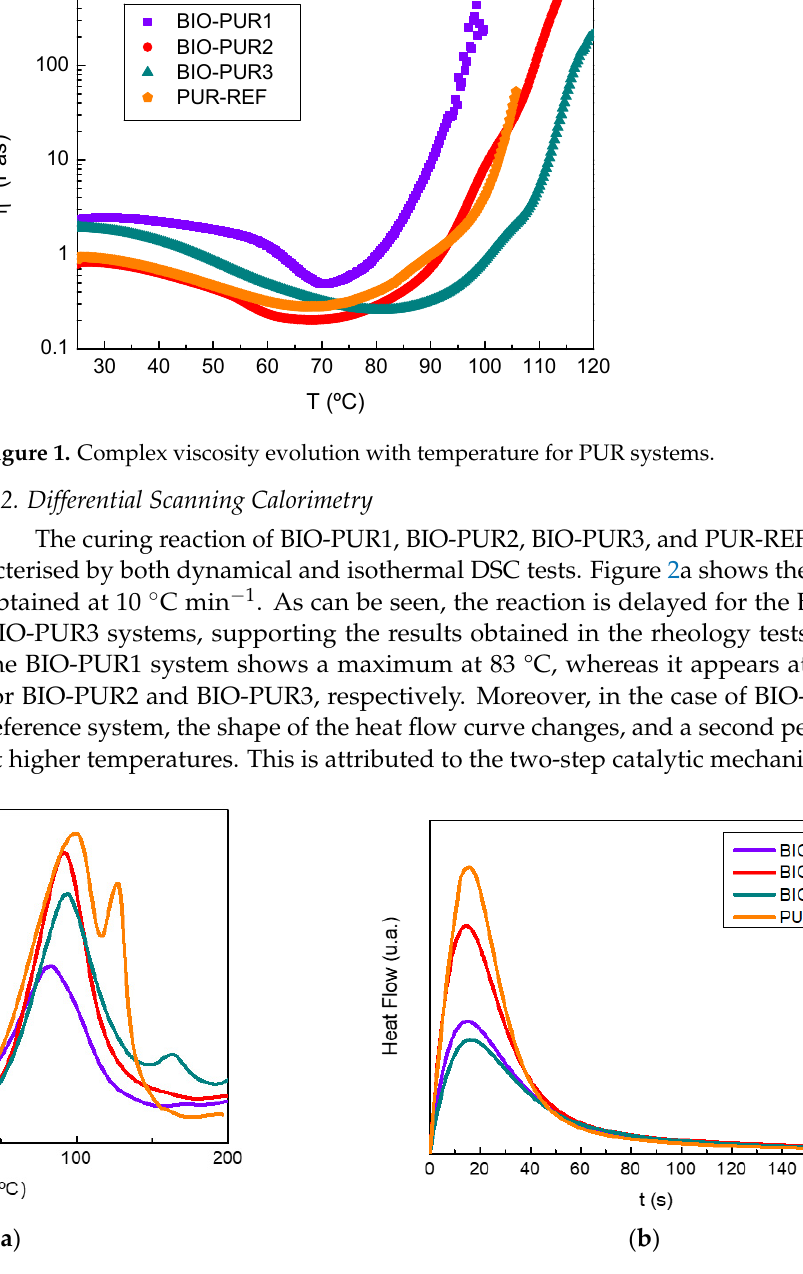
Figure 2. ( a ) Dynamic DSC thermograms and ( b ) isothermal DSC thermograms for PUR systems.